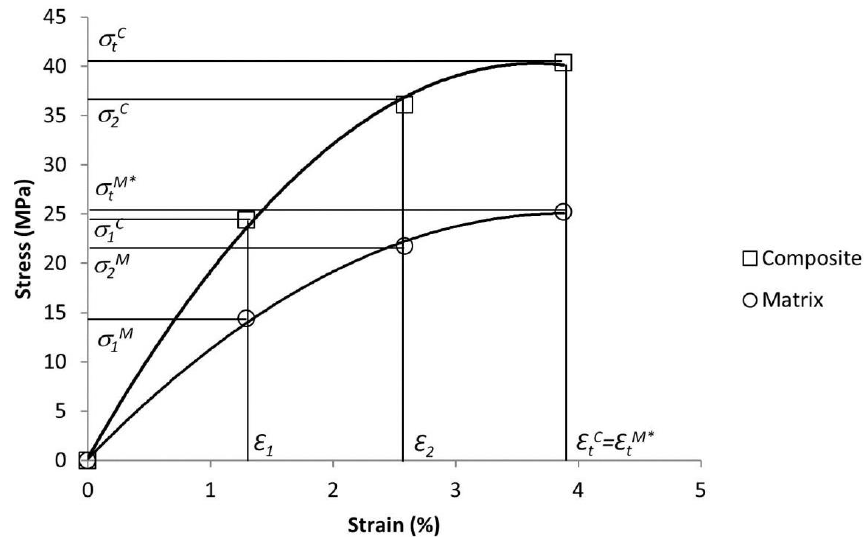
Figure 2. Typical stress-strain curves of a short-fiber semi-aligned reinforced composite and of a polypropylene (PP) matrix. The intermediate strain points used to solve the Kelly-Tyson modified equation are indicated by the 1 and 2 subscripts.